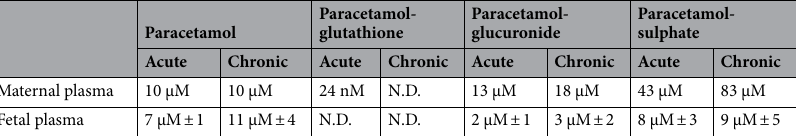
Table 4. The concentration of paracetamol and its metabolites in plasma after acute (single dose; E19) or chronic (5 day twice daily; E15–E19) maternal injection of 3.75 mg/kg paracetamol. Fetal results are ± S.D, for animal numbers see Fig. 2. N.D. not detected.